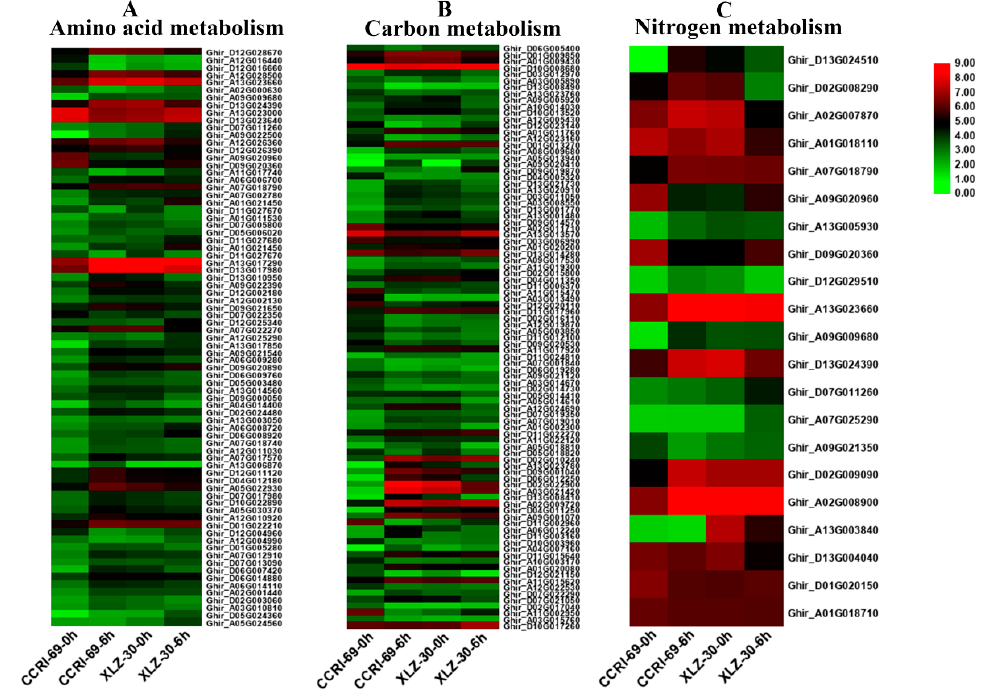
Figure 5. The expression patterns of genes involved in amino acid ( A ), carbon ( B ) and nitrogen ( C ) metabolism in shoot of two cotton genotypes. The heat map represents the relative expression levels of genes based on FPKM values using RNA sequencing (RNA-seq) data.